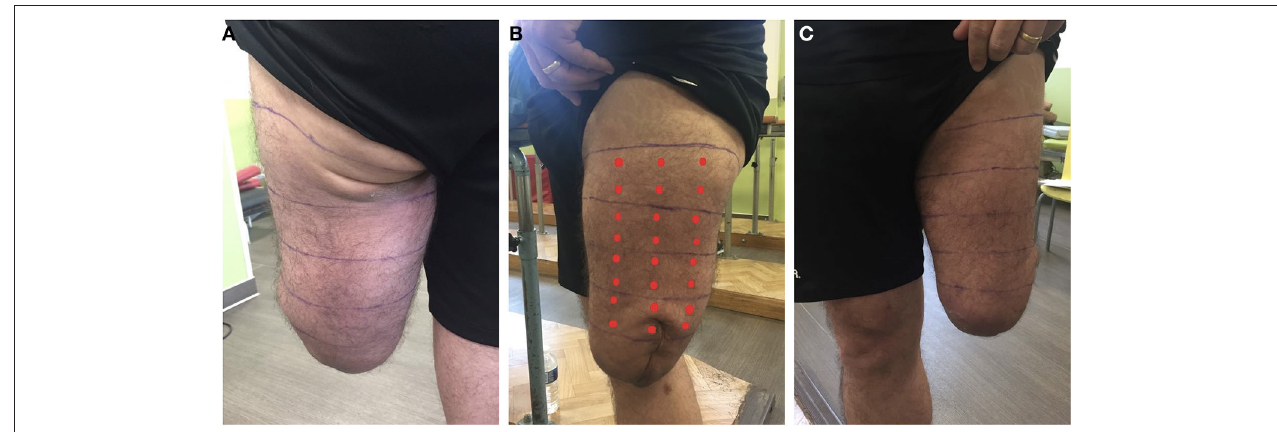
FIGURE 2 | Posterior (A) , lateral (B) , and anterior (C) views of the residual limb showing the 4 horizontal strips drawn for mapping. The most proximal horizontal delimitation was placed just under the groin and drawn perpendicular to the vertical axis of the residual limb. In each strip, 24 points around the leg were tested. The red dots in B represent the distribution of the stimulated points on one view. The part of the residual limb below the most distal strip was not tested as it was numb.